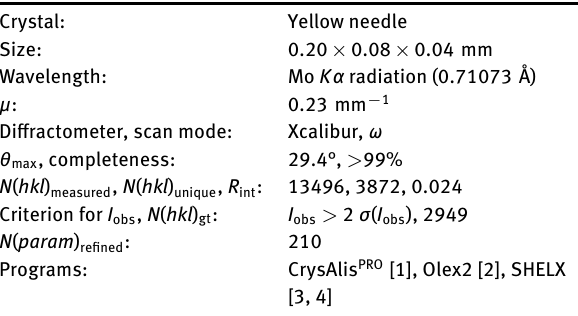
Table 1: Data collection and